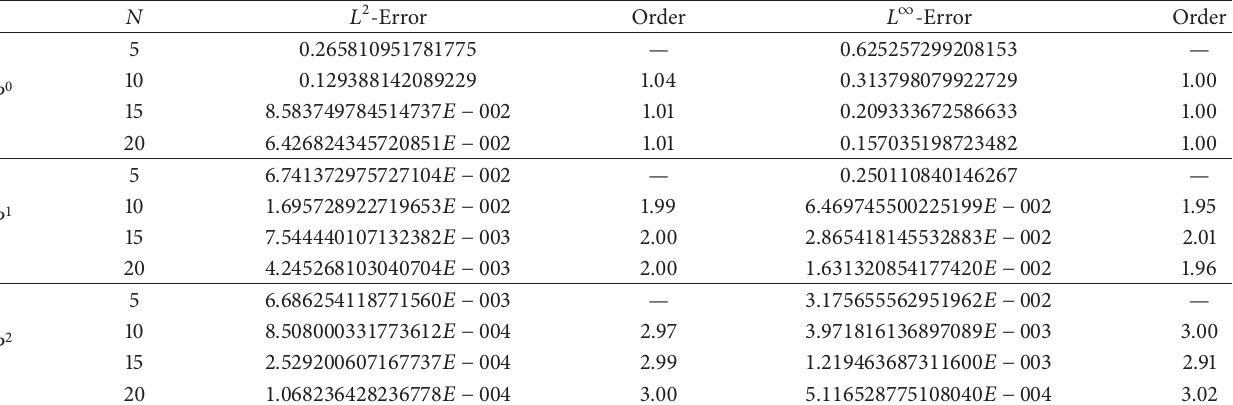
Table 4: Spatial accuracy test for the fractional order equation with the forcing term (42). 𝛼 = 0.4 , 𝑀 = 10 4 , 𝑇 = 1 . 𝑁 𝐿 2 -Error Order 𝐿 ∞ -Error